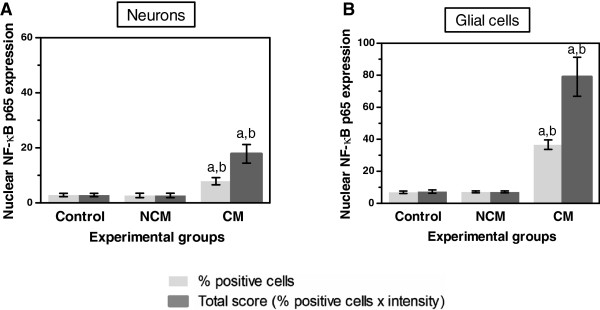
Expression of nuclear NF-κB p65 in the brain of control, NCM, and CM groups in neurons (A) and glial cells (B). aSignificance of p < 0.001 compared with control brain (Mann–Whitney U test). bSignificance of p = 0.034 compared with NCM (Mann–Whitney U test). Data are presented as mean ± SEM.